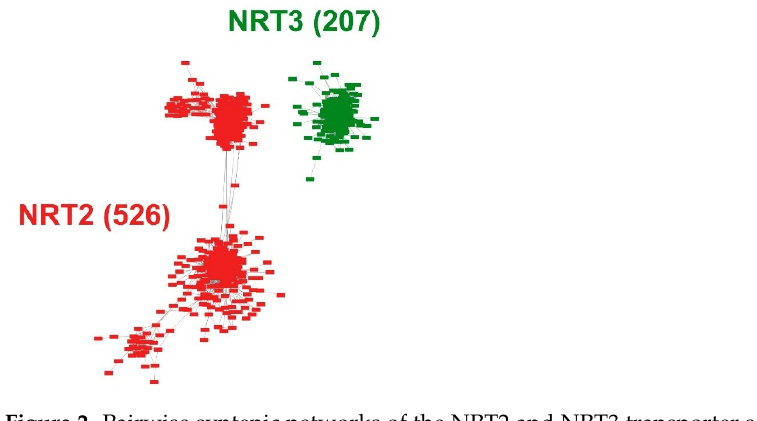
Figure 2. Pairwise syntenic networks of the NRT2 and NRT3 transporter sequences. The synteny relationships were obtained through the MCScanX program and visualized through the Cytoscape program. Nodes represent protein-coding genes, and edges represent pairwise synteny